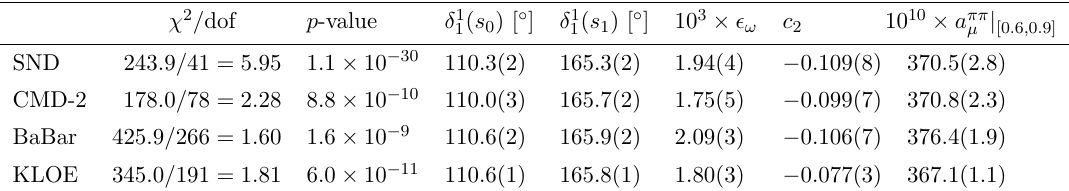
Table 2. Fit results for (cid:12)xed ! parameters. The uncertainties are the (cid:12)t errors only. The value